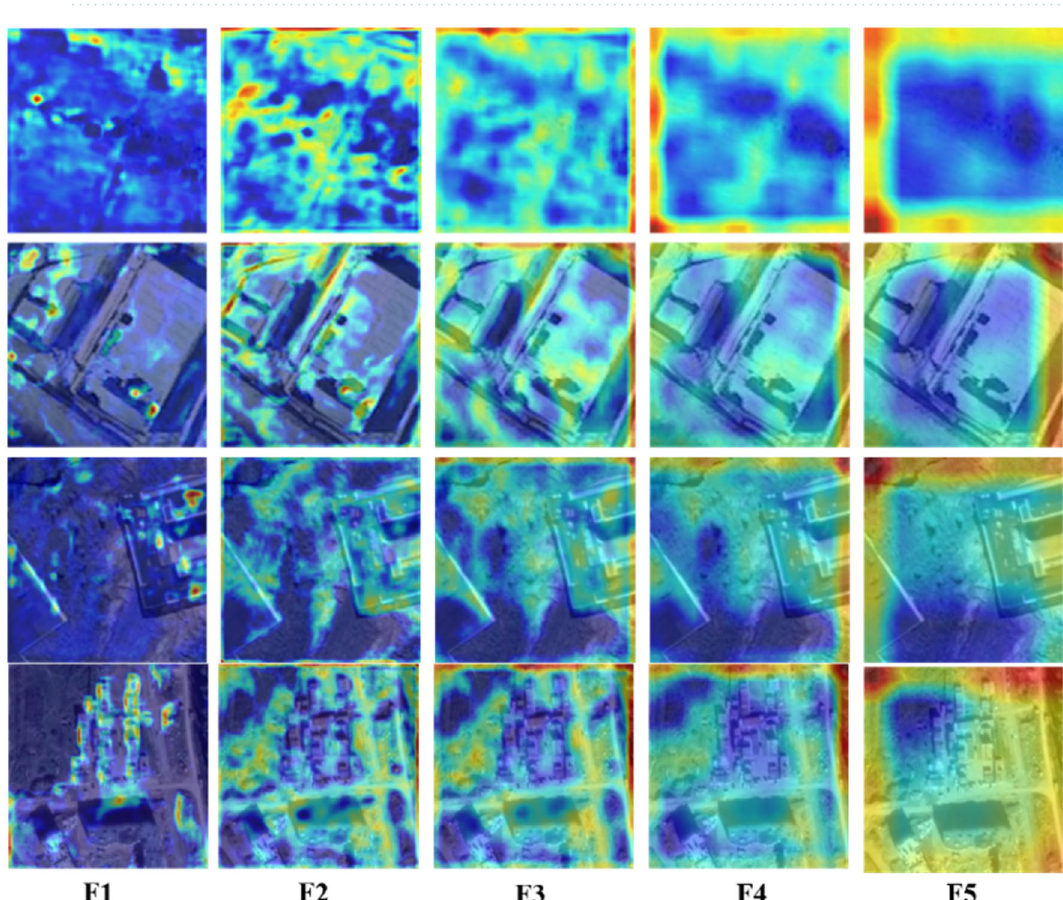
Figure 12. Visualization of feature maps output from different scale pooling layers on CDD dataset (created by ‘Microsoft Office Visio 2013’ url: https:// www. micro soft. com/ zh- cn/ micro soft- 365/ previ ous- versi ons/ micro soft- visio-